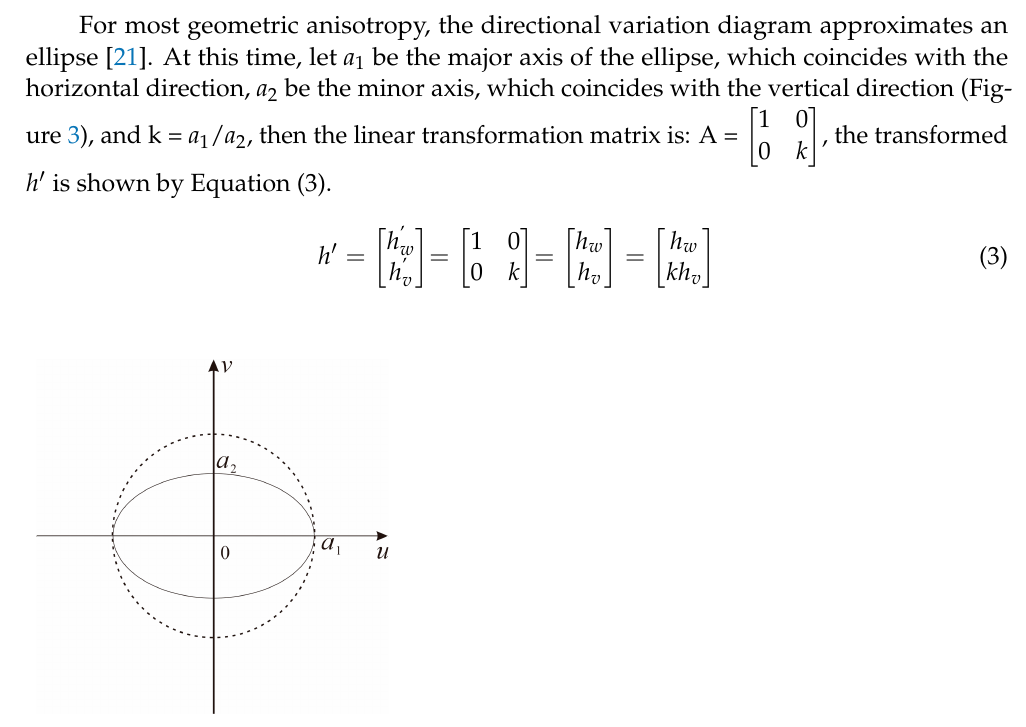
Figure 3. Ellipse stretching transformation.